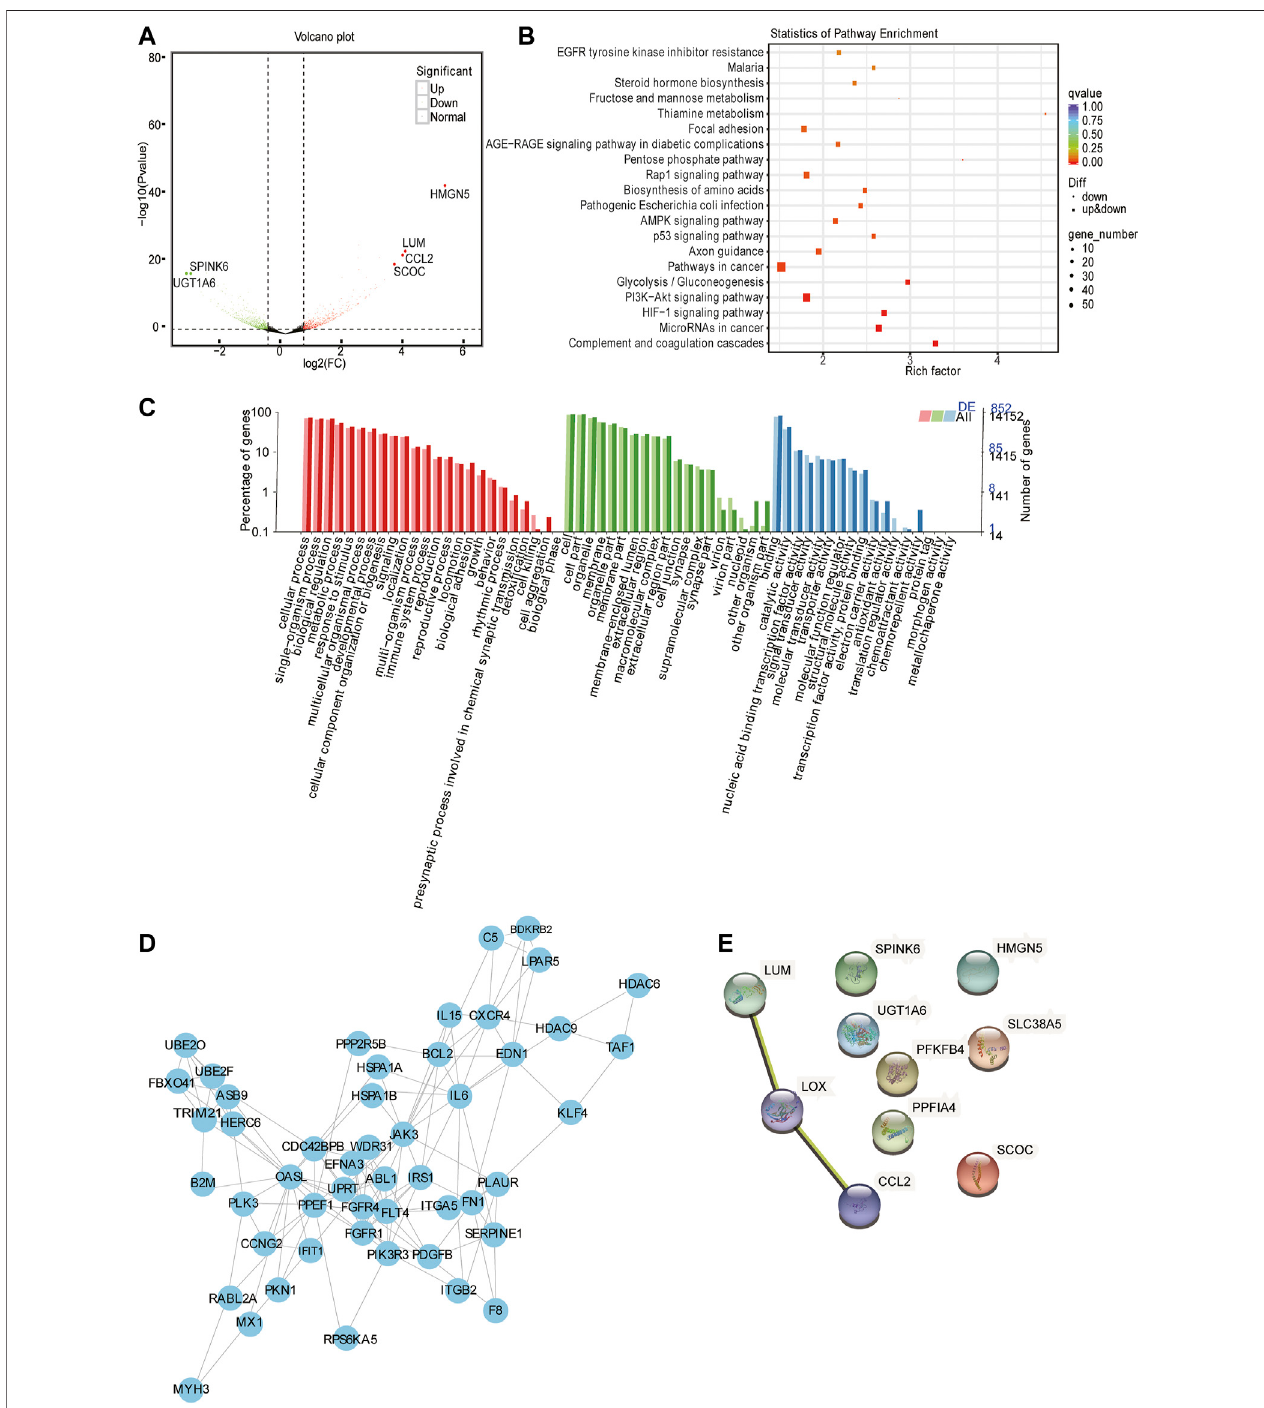
FIGURE 3 | Analysis of mRNA-seq. (A) Volcano plot displaying gene expression alterations in HIF1A-KO cells compared to those of the control. The red points represent upregulated DEGs and the blue points represent downregulated DEGs. Black points represent RNAs with no difference in expression. (B) Top 20 KEGG pathway enrichment of DEGs. The x-axis indicates the rich factor and the y-axis indicates the pathway names. (C) GO analysis of DEGs through diverse GO categories. The red column represents the biological process; the green column represents the cellular component; the blue column represents the molecular function. (D) Protein – protein interaction network based on STRING database analysis and Cytoscape. (E) PPI analysis of top 10 regulated DEGs.